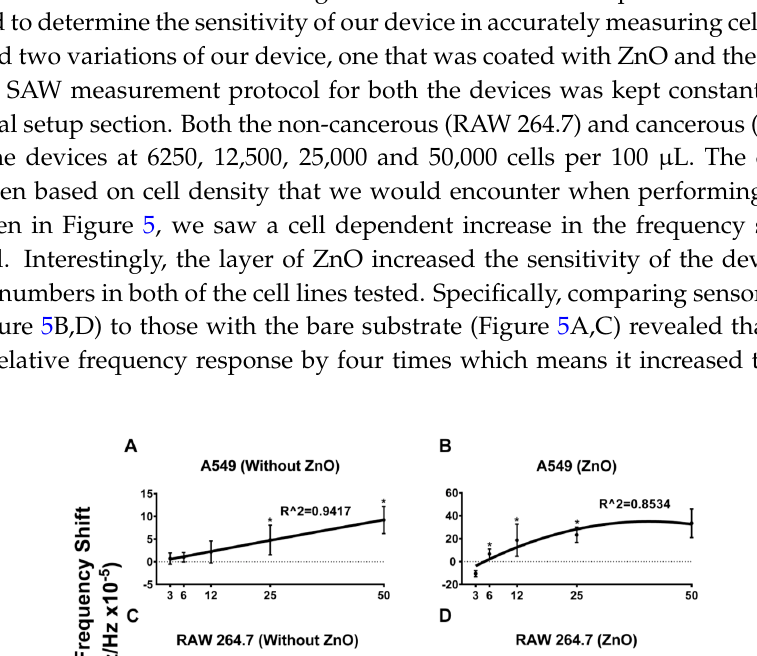
Figure 4. Cell proliferation following SAW measurement. Immediately following SAW measurement A549 cells were seeded onto a 96-well plate at a density of 5000 cells per well. Representative images of control and tested groups are shown: ( A ) A549 cells 72 h after SAW test; ( B ) NucBlue staining of A549 cells 72 h after test; and ( C ) Control cells after 72 h.